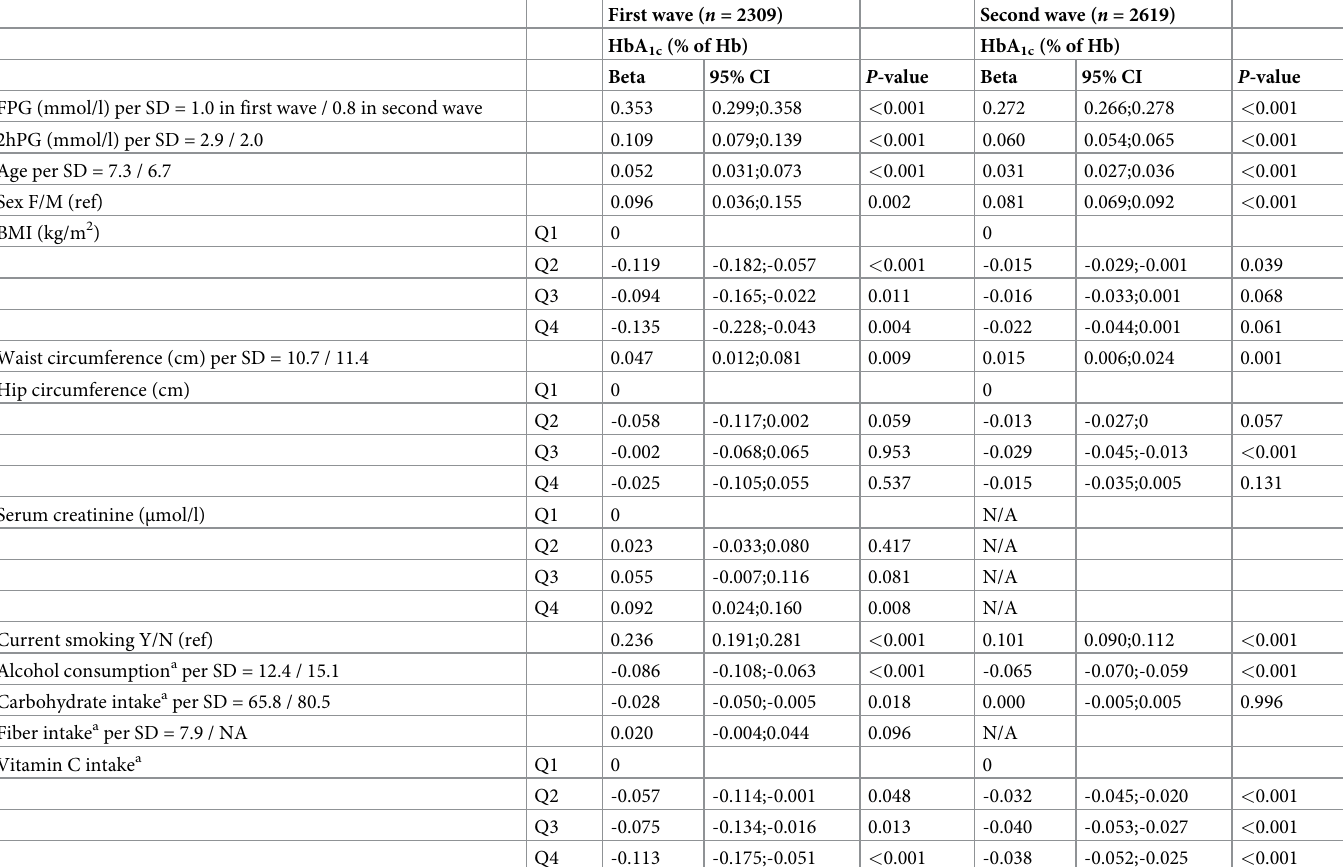
Table 2. Multivariate linear regression models of associations of demographic, anthropometric, clinical and nutritional determinants with HbA1c independent of glucose in the Hoorn